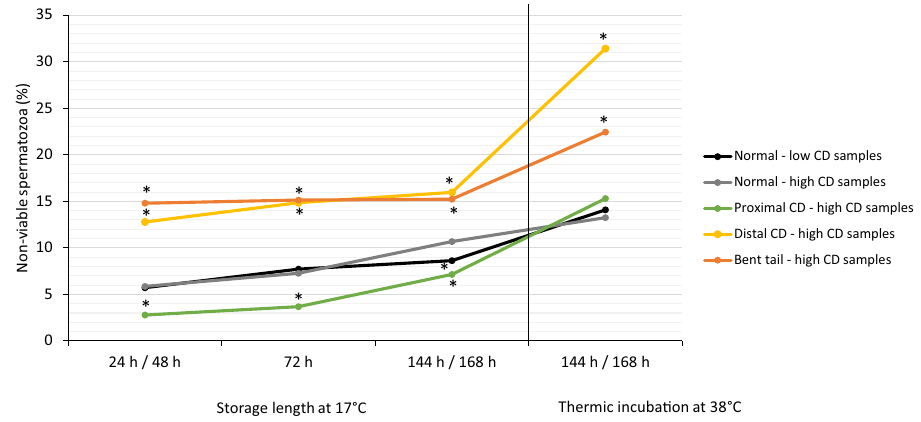
Figure 7. Prevalence of non-viable sperm with normal tail morphology or with proximal or distal CD or bent tail during storage at 17 °C up to 168 h and subsequent thermic incubation at 38 °C for 3 h. Extended semen originated from samples with either enhanced (≥ 15% = high MAS; n = 15 boars) or low (< 5% = low MAS; n = 11 boars) prevalence of cytoplasmic droplets and/or bent tails. An asterisk (*) indicates a significant difference between sperm with a CD or bent tail and normal sperm within a time point ( p < 0.05). There were no differences between normal sperm from high and low MAS samples ( p >